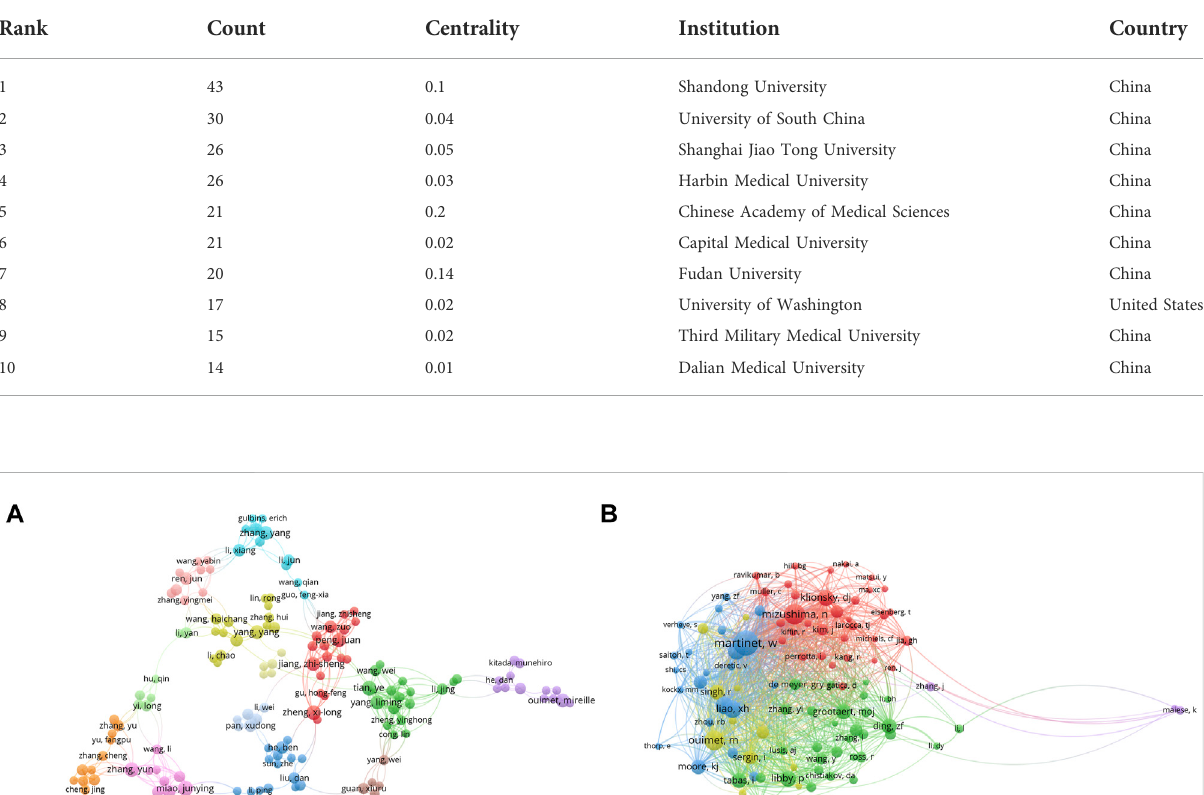
TABLE 2 Top 10 institutions with the most publications.